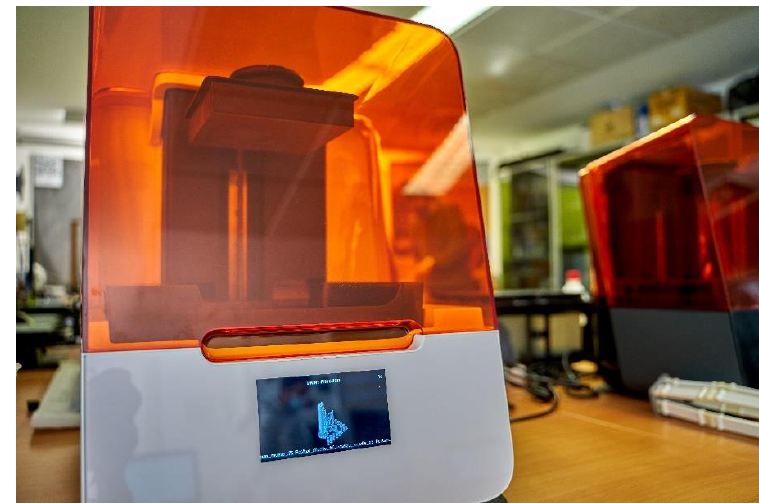
Figure 2. SLA machine ready to print with Tough 2000 Resin.